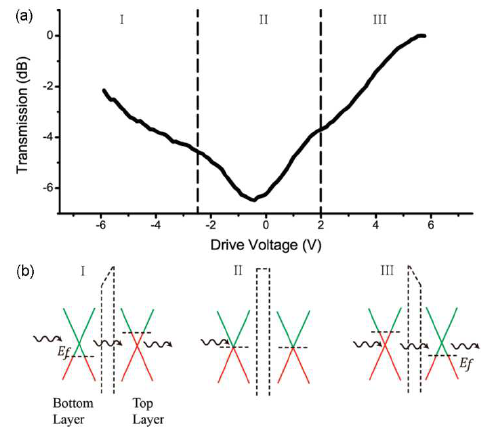
Figure 11. Performance observation of a graphene modulator having a double layer. Using a 1.537 µ m wavelength and 40 µ m long device, the modulation depth can be around 6.5 dB ( a ) transmission of photons with respect to voltage; ( b ) photons for different regions, green and red indicate unoccupied and occupied region. Reprinted with permission from [13]. Copyright (2012) American Chemical Society.